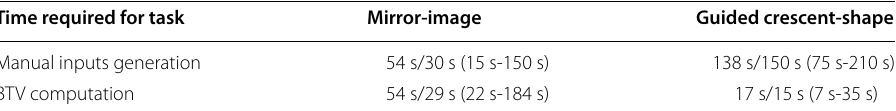
Table 3 Time taken for manual input generation and BTV computation for a single repeat [average/ median (range)]